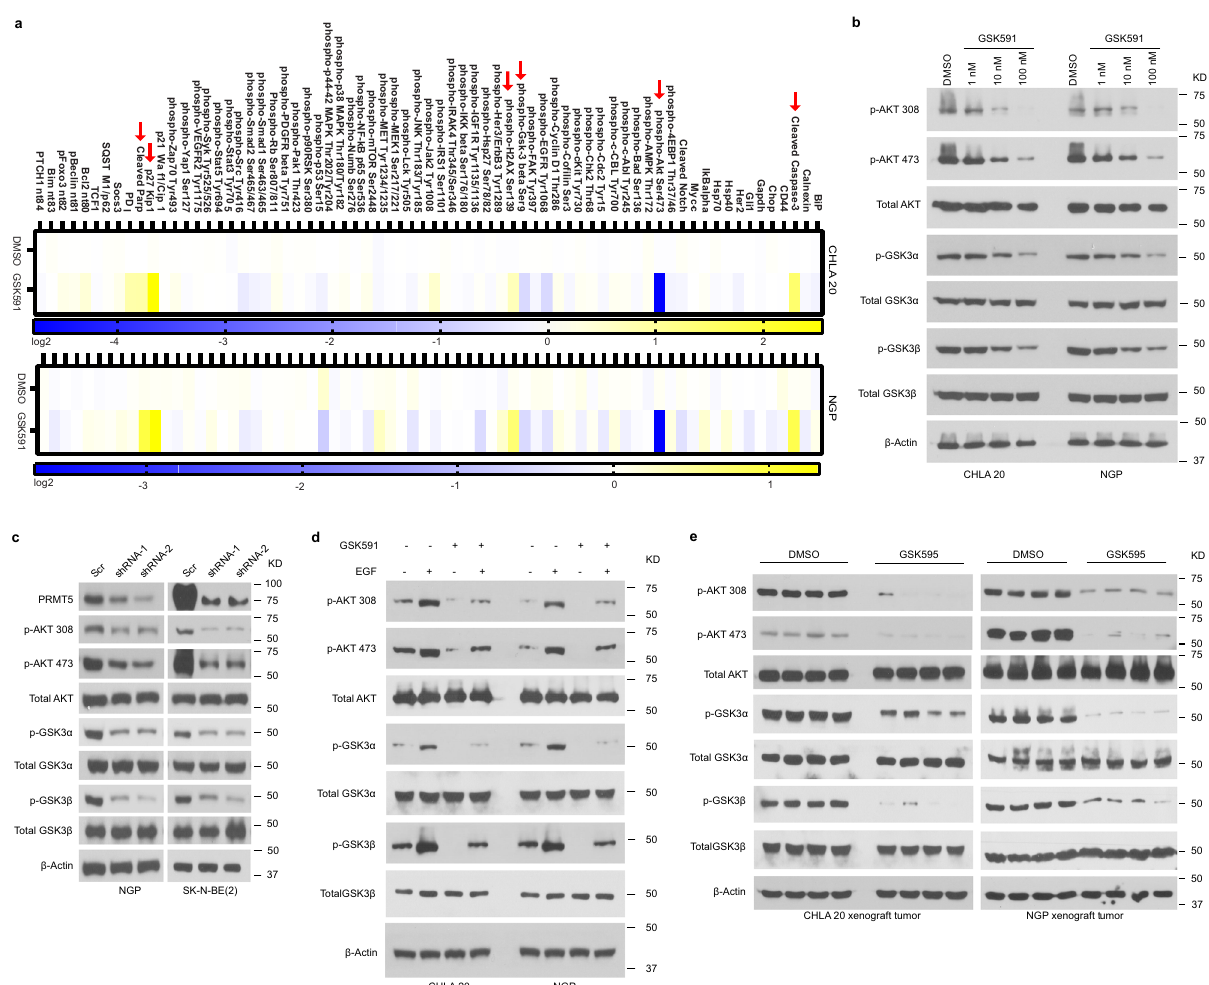
Fig. 3 PRMT5 inhibition impairs AKT signaling. a Proteomics-based pathway screening by IPAD platform (immuno-paired-antibody detection assay) for the expression or modi fi cation of key proteins involved in more than 20 signaling pathways. Signals were normalized to internal levels of GAPDH and beta Tubulin. Heatmap showed differences between DMSO and GSK591 groups based on the average value from two independent experiments ( n = 2 biologically independent samples). The color scale represented log2 fold changes over DMSO treatment. b Immunoblots showing phosphorylation of AKT, and its downstream targets phospho-GSK3 α and phospho-GSK3 β in CHLA20 and NGP cells treated with DMSO or increasing doses of GSK591. c Western blots of AKT phosphorylation and AKT downstream targets phospho-GSK3 α and phospho-GSK3 β in the presence and absence of PRMT5 in NGP or BE2 cells harboring scramble or shPRMT5. d Levels of phosphorylated AKT, GSK3 α , and GSK3 β with or without EGF stimulation in DMSO and GSK591-treated CHLA20 and NGP cells. e Activated AKT and its targets phospho-GSK3 α and phospho-GSK3 β were detected by Western blotting in xenograft tumors from vehicle or GSK595-treated mice. b – d Representative results from three independent experiments. Uncropped immunoblots are provided in the Source Data fi